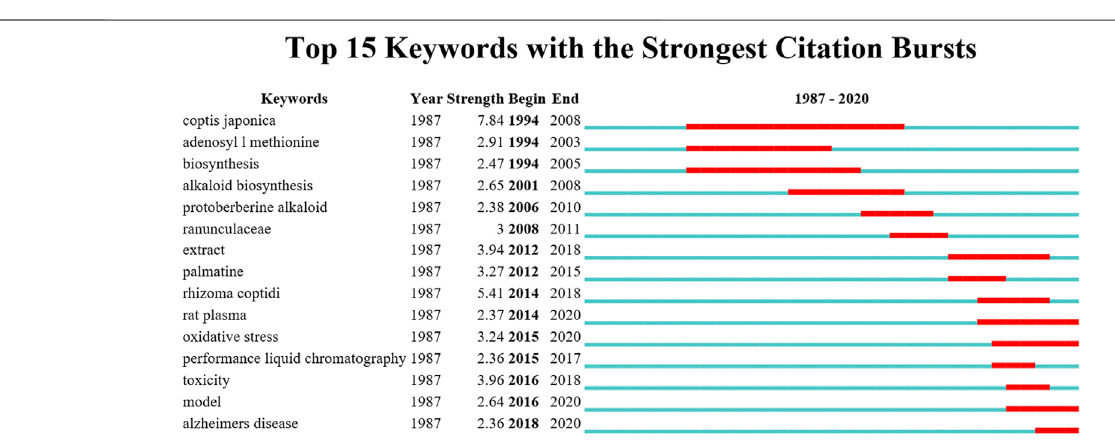
FIGURE 9 | Top 15 keywords with the strongest citation